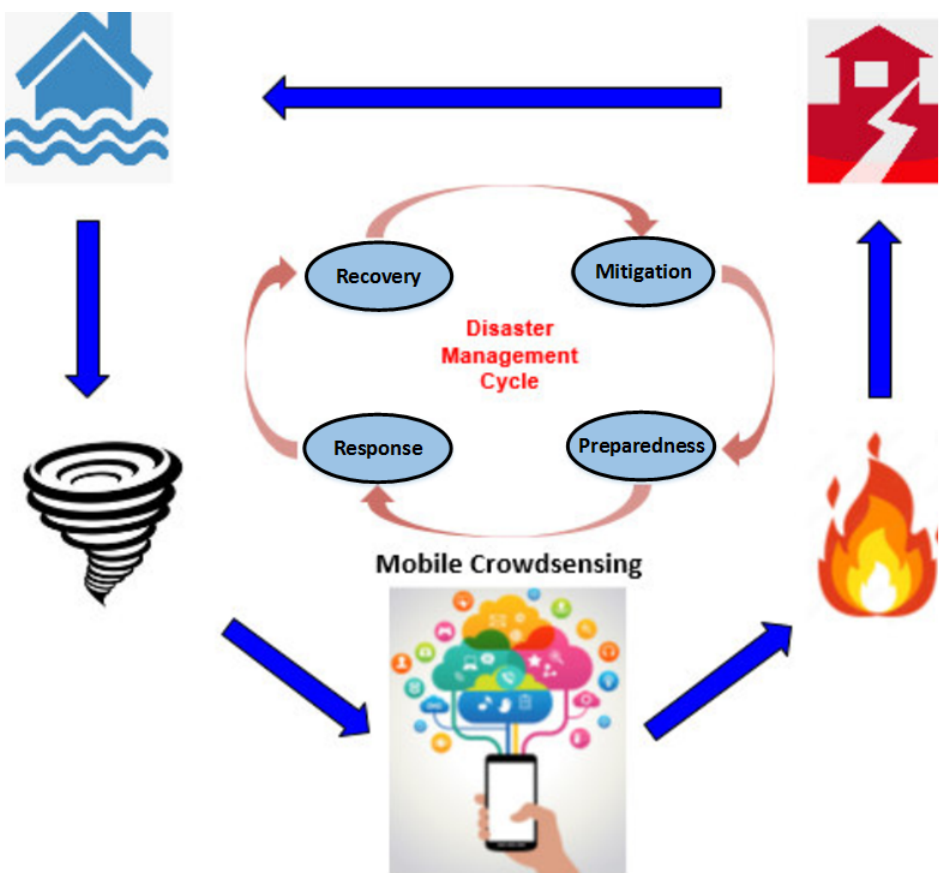
Figure 1. Mobile Crowdsensing-Aided Disaster